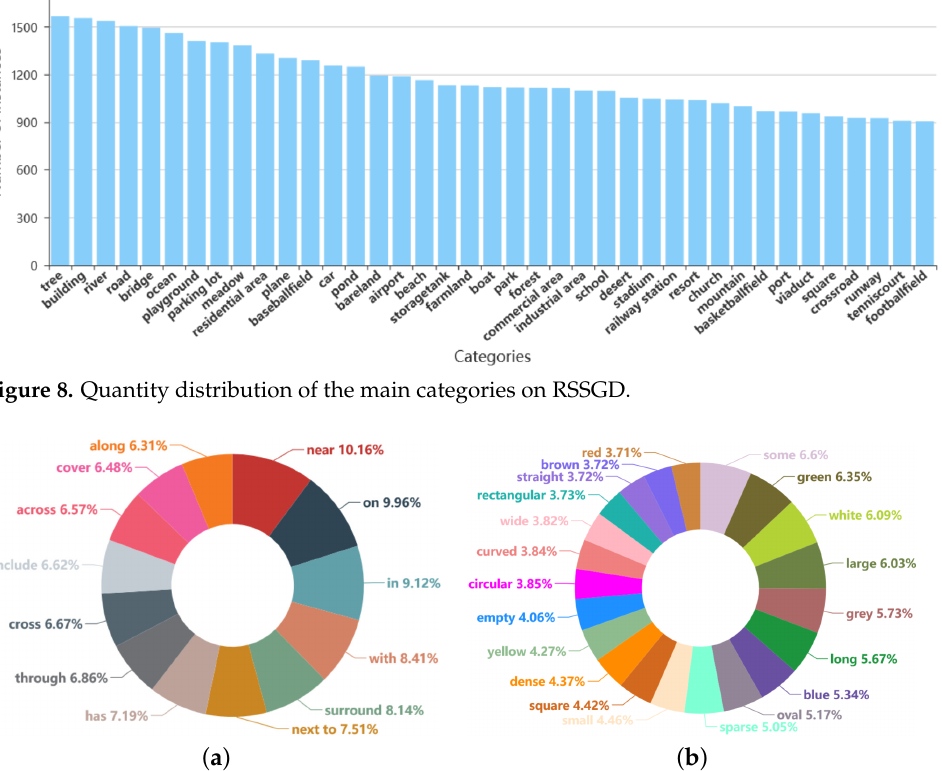
Figure 9. Statistical results of the mainly relationships and attributes on RSSGD. ( a ) is the statistical result about relations. ( b ) is the statistical result about